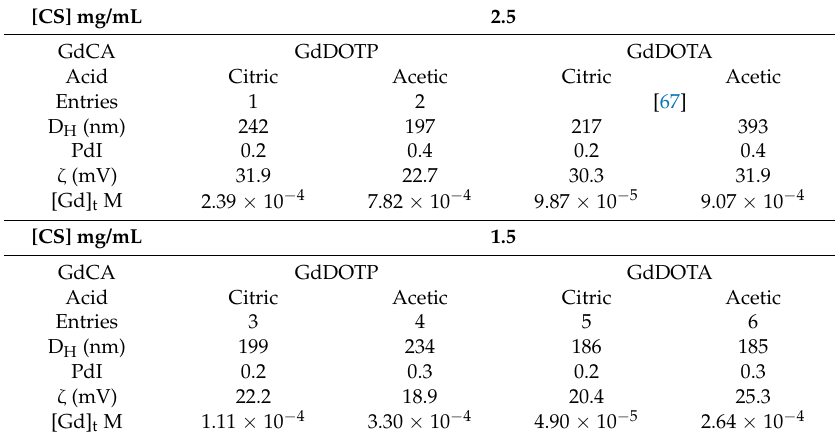
Table 1. Nanogel characteristics and Gd(III) loadings of GdCA ⊂ CS-TPP/HA nanogels (NGs) according to chitosan (CS) concentration in the acid (citric or acetic)